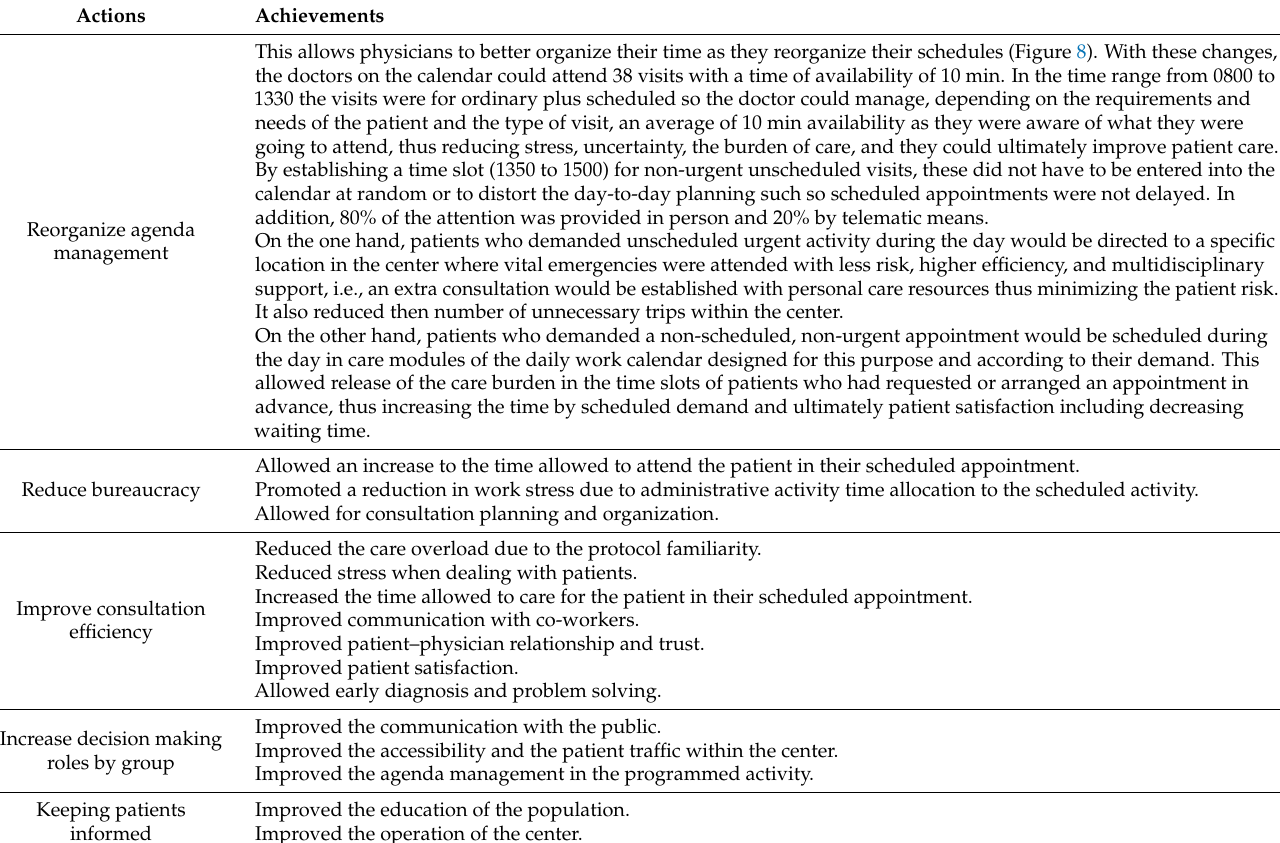
Table 7. Action plan and